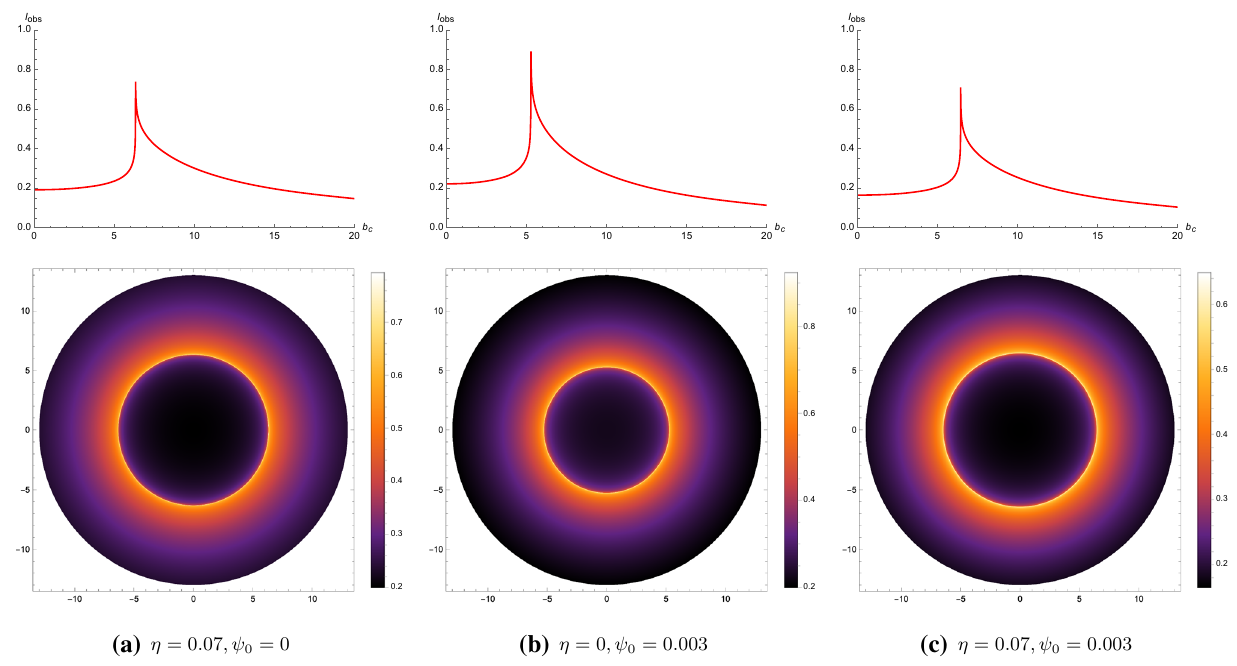
Fig. 8 The specific intensity I obs (ν o ) seen by a distant observer for a static spherical